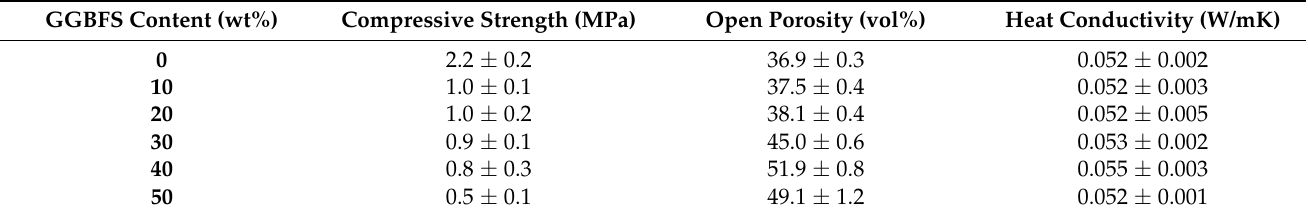
Table 5. Effect of slag addition on the physical properties of